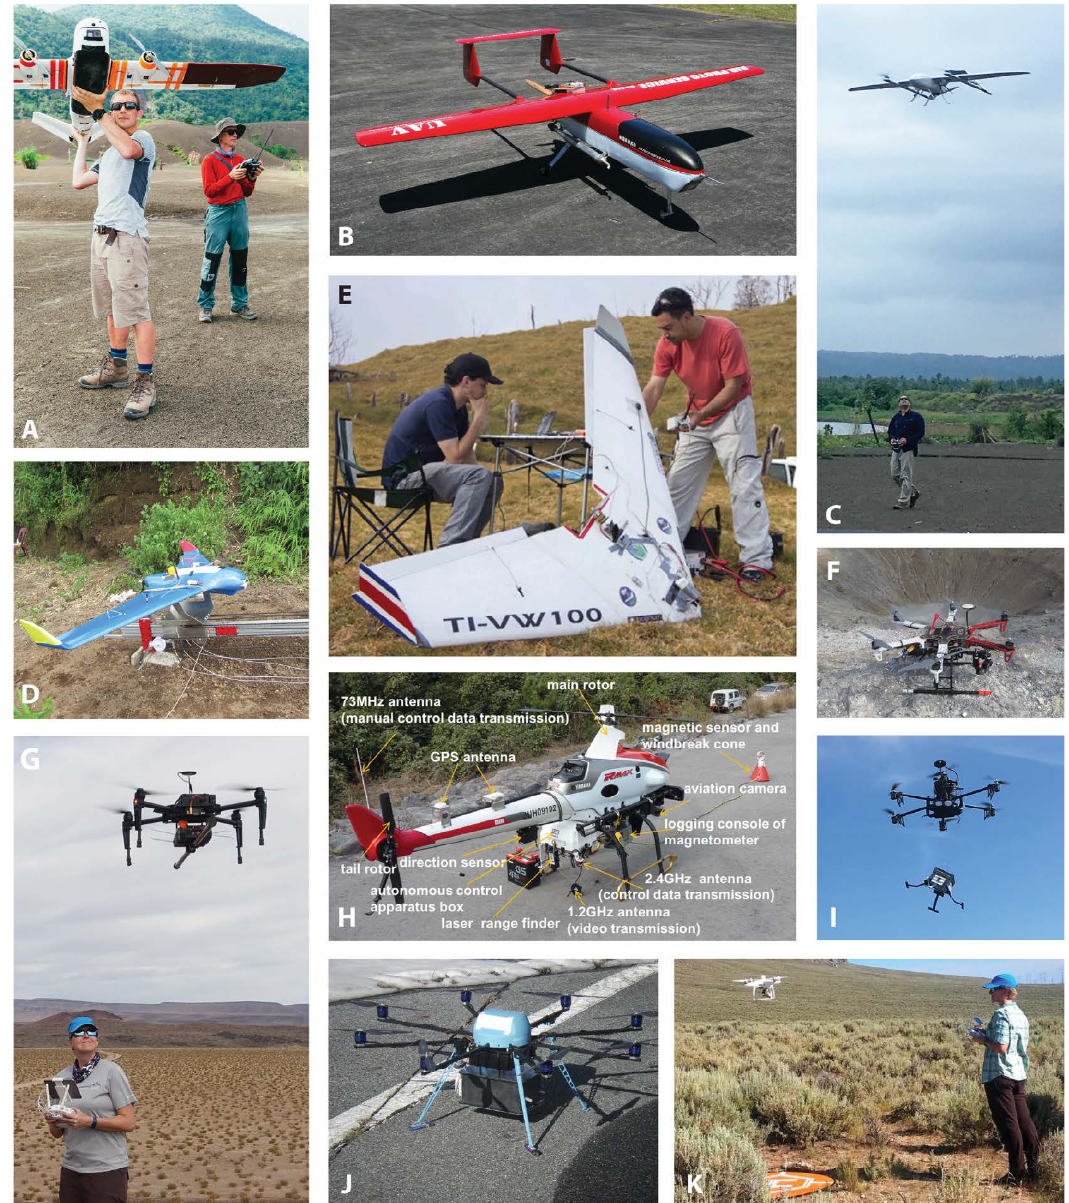
Figure 1: Examples of UAS platforms. [A] A 2.2-m-wingspan fixed-wing Skywalker Titan airframe with custom avionics, used for long-range aerial gas measurements at Manam, Papua New Guinea. [B] A 2.8-m-wingspan air- craft from Air Photo Service Inc., Japan used for imaging lava flow activity on Nishinoshima island [Nakano et